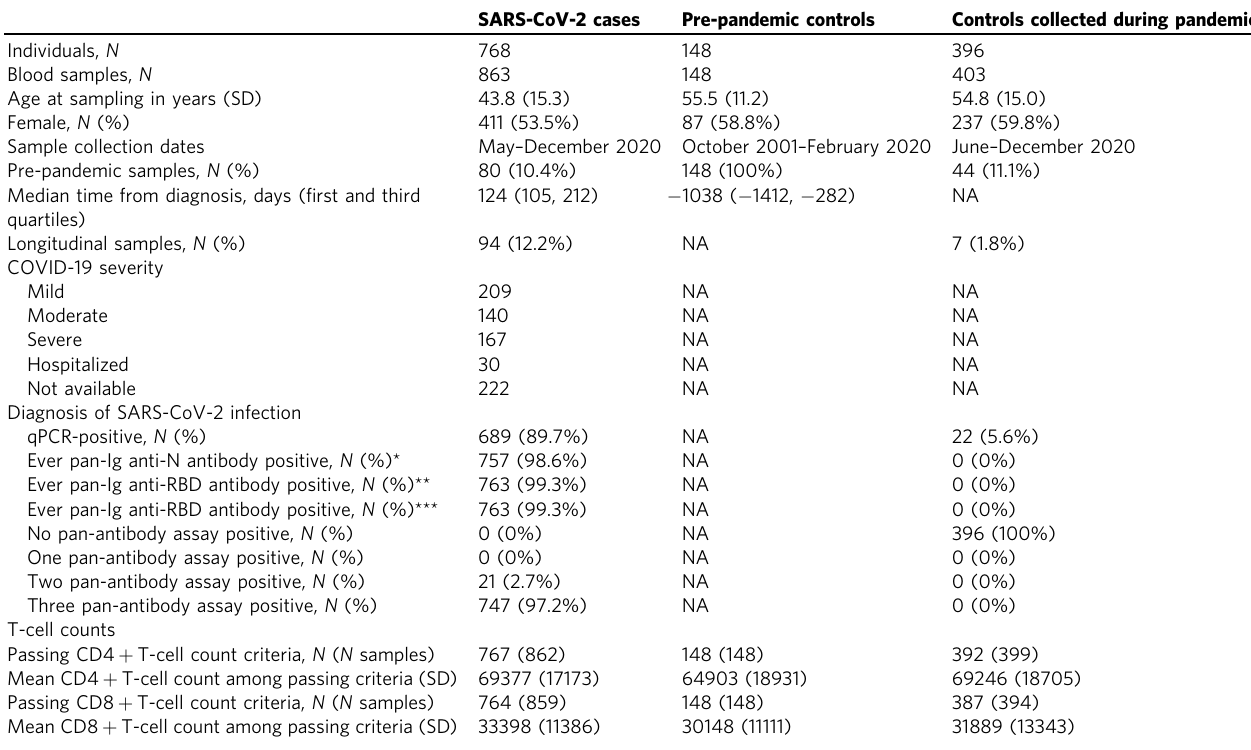
Table 1 Characteristics of persons contributing blood samples for the